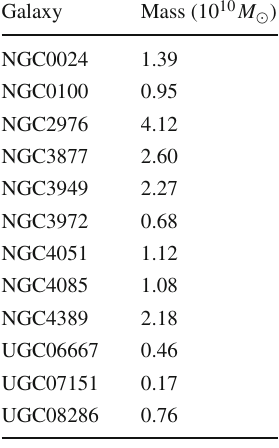
Table 2 The predicted mass of the dark halo for the 12